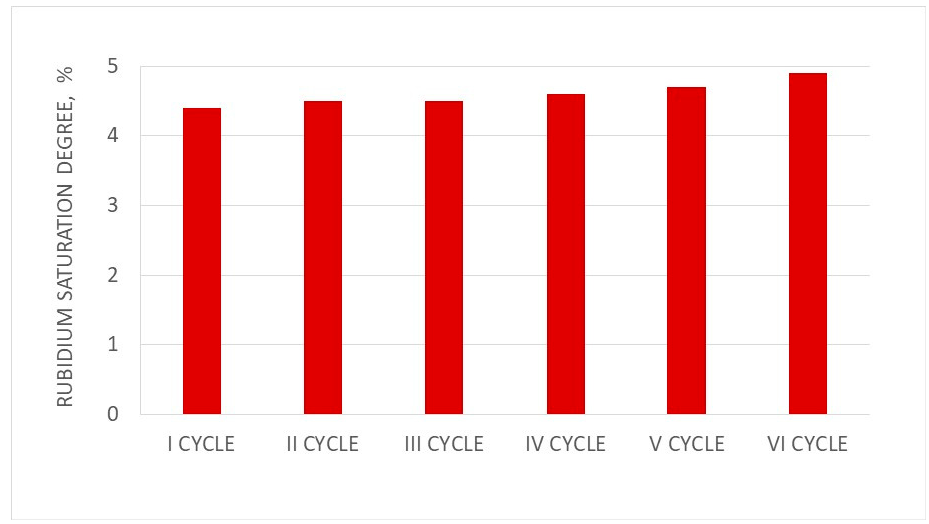
Figure 10. Changes in the elution efficiency in subsequent cycles (I–VI).